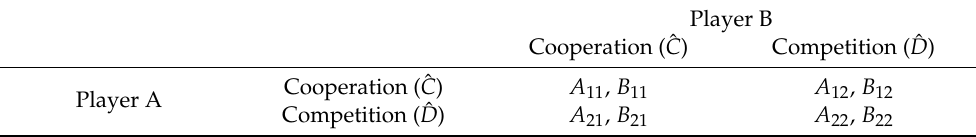
Table 1. Basis vector game